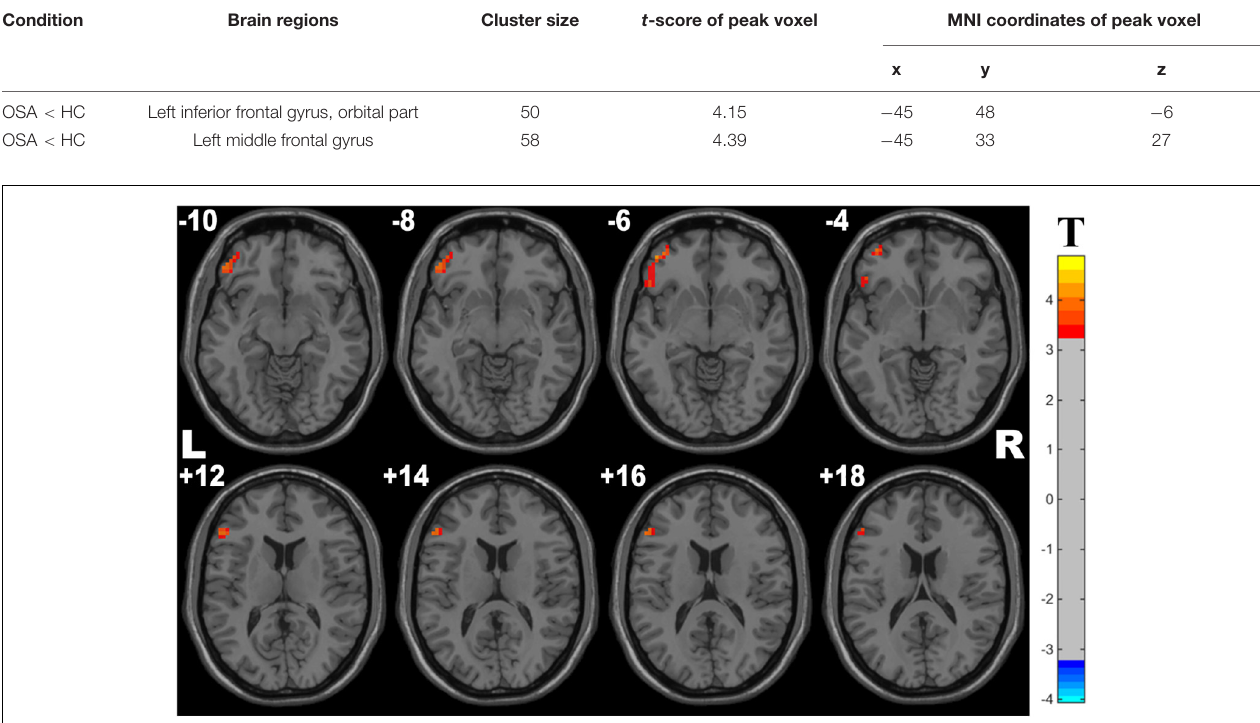
( r = − 0.381, p = 0.046), AI ( r = − 0.391, p = 0.040), and a significantly positive correlation with LSaO 2 ( r = 0.378, p = 0.047). The mean fALFF value in the left precuneus showed a significantly negative correlation with LSaO 2